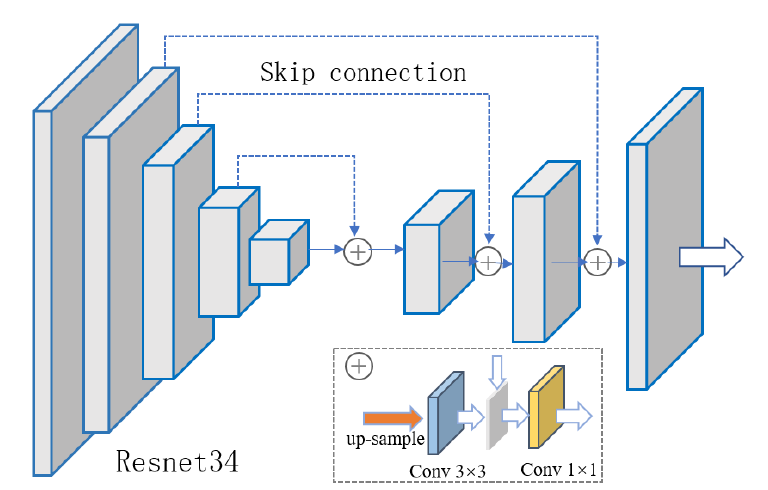
Figure 7. Feature extraction network (Res34 +